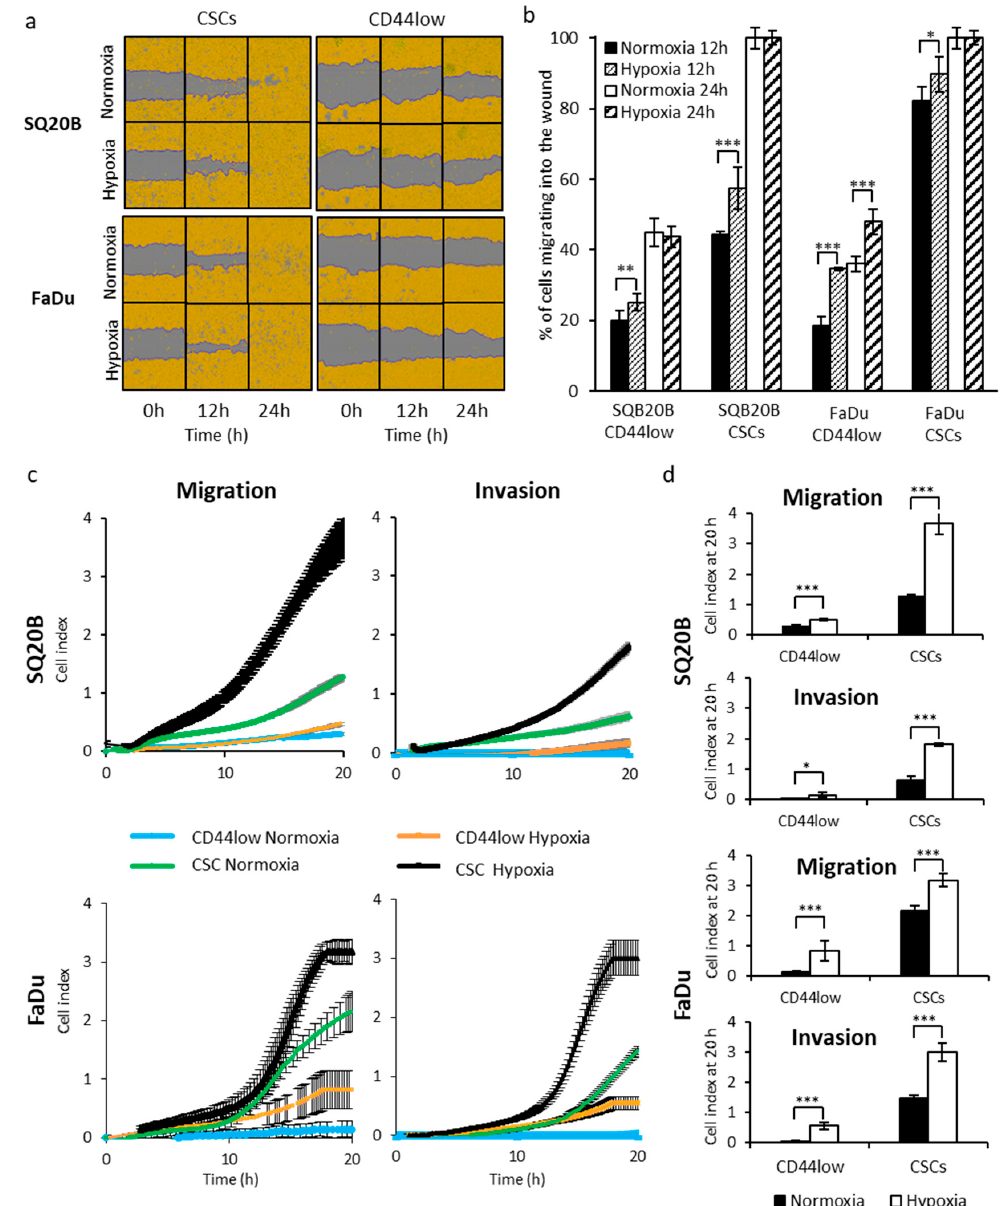
Figure 1. E ff ect of hypoxia on the motility, cell migration and invasiveness of head-and-neck squamous cell carcinoma (HNSCC)-cancer stem cells (CSCs) and non-CSC subpopulations. ( a ) Representative images of wound-healing assay obtained using IncuCyte at 0, 12 and 24 h after cell scraping in normoxic or acute hypoxic conditions ( n = 2, triplicates). ( b ) Quantification of the wound rate recovery in normoxia and acute hypoxia, 12 h after cell scraping. Significance was assessed for hypoxia compared with the corresponding normoxic condition (* p < 0.05, ** p < 0.01, *** p < 0.005, Student’s t test). ( c ) Real-time analyses of cell migration / invasion under normoxia or hypoxia followed over 20 h with xCELLigence (mean ± SD of 4 wells), n = 3. ( d ) Migration and invasion cell index obtained with xCELLigence at 20 h in normoxia and hypoxia. Normoxic and correspondent hypoxic cell index were compared using Student’s t test.